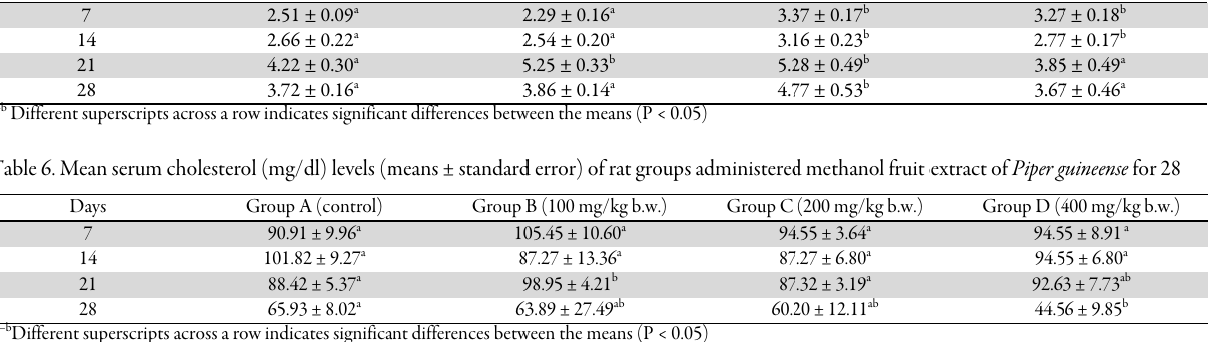
Different superscripts across a row indicates significant differences between the means ( Table 5. Mean serum globulin (g/dl) levels (means ± standard error) of rat groups administered methanol fruit extract of Table 5. Mean serum globulin (g/dl) levels (means ± standard error) of rat groups administered methanol fruit extract of Table 5. Mean serum globulin (g/dl) levels (means ± standard error) of rat groups administered methanol fruit extract of Table 5. Mean serum globulin (g/dl) levels (means ± standard error) of rat groups administered methanol fruit extract of Table 5. Mean serum globulin (g/dl) levels (means ± standard error) of rat groups administered methanol fruit extract of Table 5. Mean serum globulin (g/dl) levels (means ± standard error) of rat groups administered methanol fruit extract of Table 5. Mean serum globulin (g/dl) levels (means ± standard error) of rat groups administered methanol fruit extract of Table 5. Mean serum globulin (g/dl) levels (means ± standard error) of rat groups administered methanol fruit extract of Piper Days Group A (control) Group B (100 mg/kg b.w.) mg/kg b.w.) Group C (200 mg/kg b.w.)